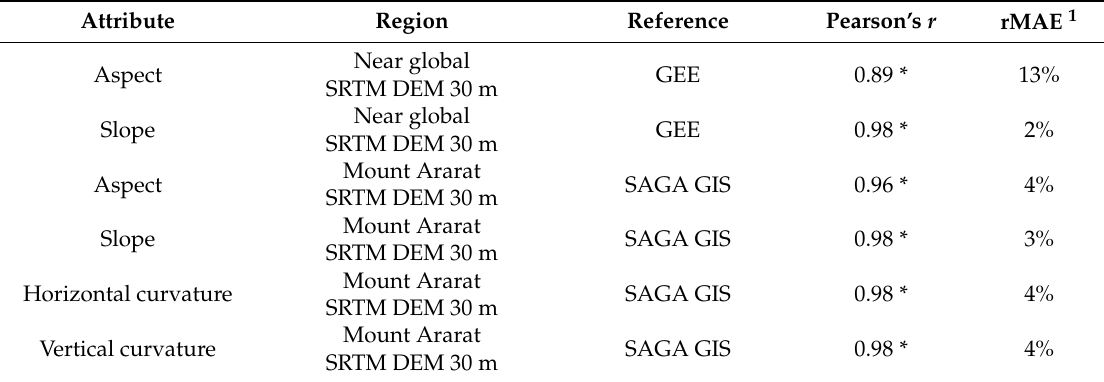
GEE 0.89 * 13% SAGA GIS 0.96 * 4% SAGA GIS SAGA GIS 0.98 * 4% SAGA